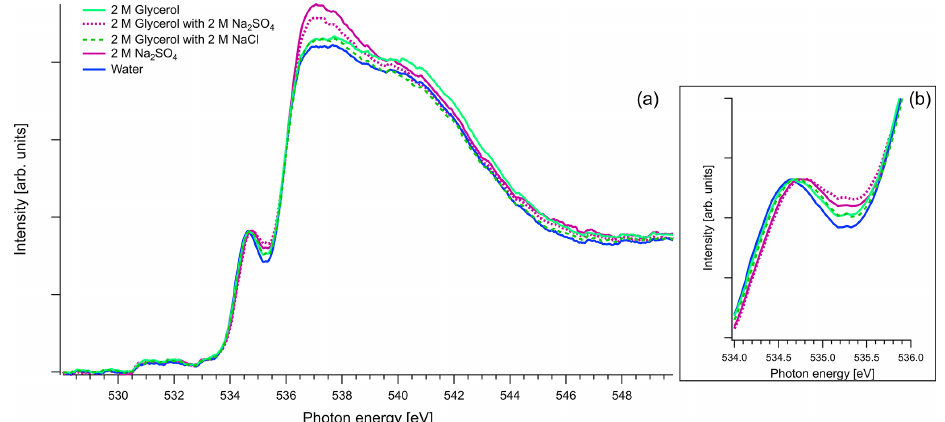
Figure 8. (a) Recorded spectra of aqueous solutions of glycerol, in oxygen K edge. Comparison of aqueous solution of 2M of glycerol and 1:1 molar mixtures with Na 2 SO 4 and NaCl. The spectra of binary water–2M Na 2 SO 4 solution and pure water are also presented for comparison reasons. All the spectra are normalized to the pre-peak at 535eV. (b) Zoom on the pre-peak of the spectrum.